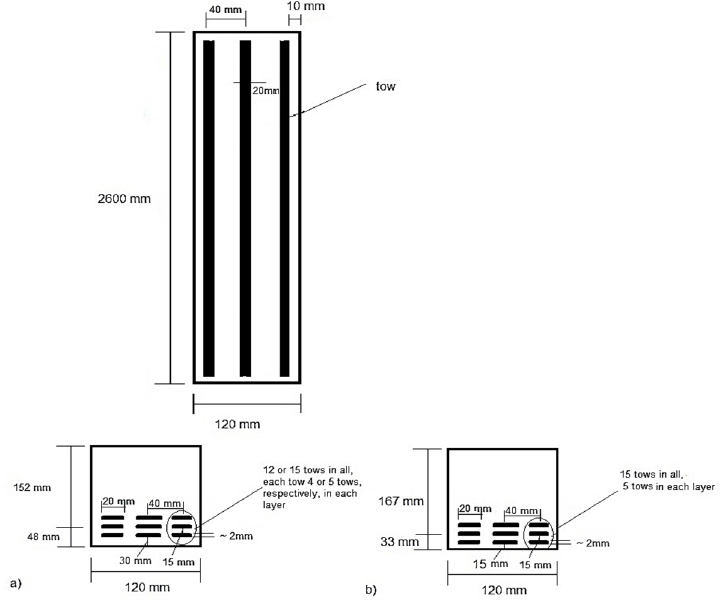
Figure 6. The arrangement of textile layouts in uni-axial TRC beams; ( a ) 3UT 12 or 15 -Anch-L 3 -2.6, ( b ) 3UT 15 -Anch-L 3 -2.6-C 15 .